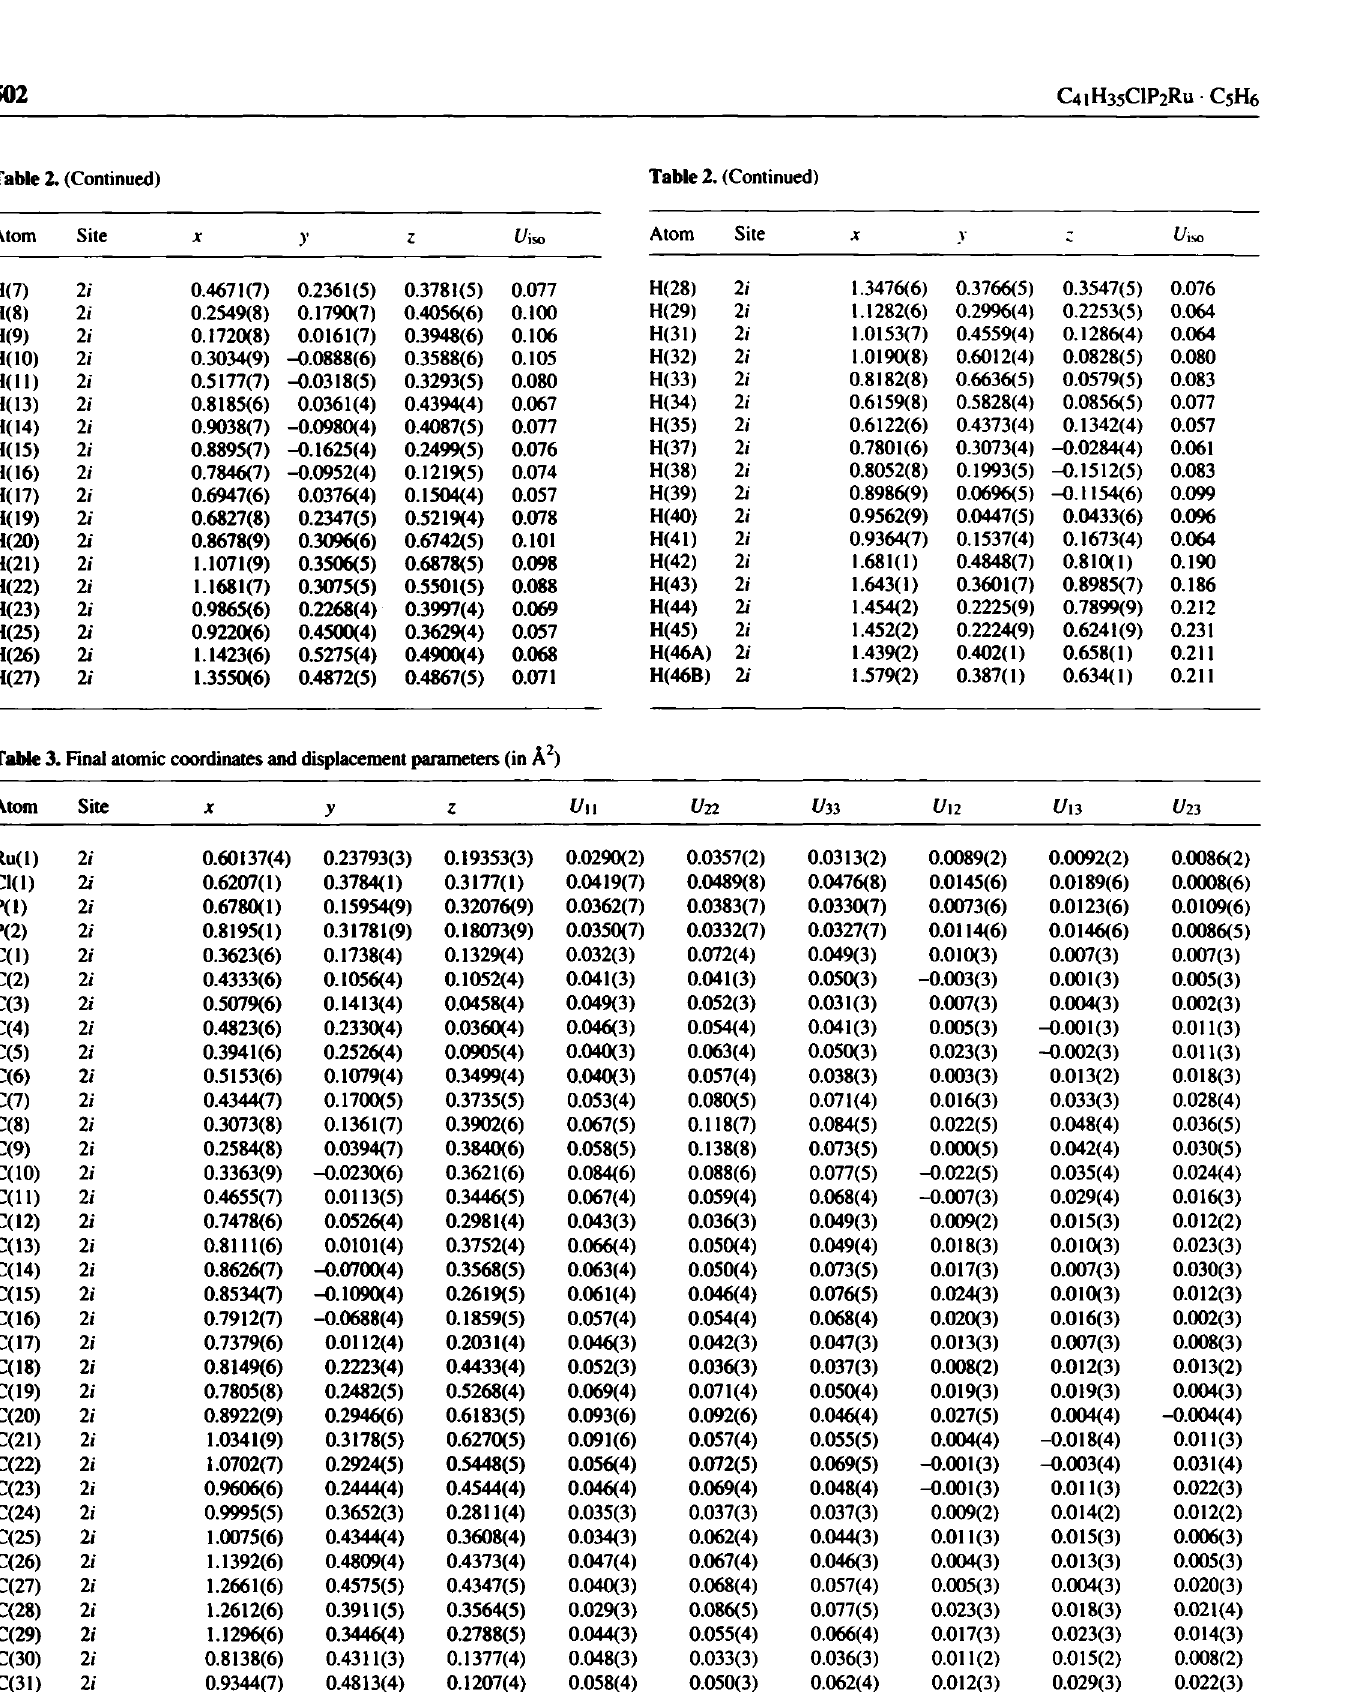
Table 3. Final atomic coordinates and displacement parameters (in Â 2